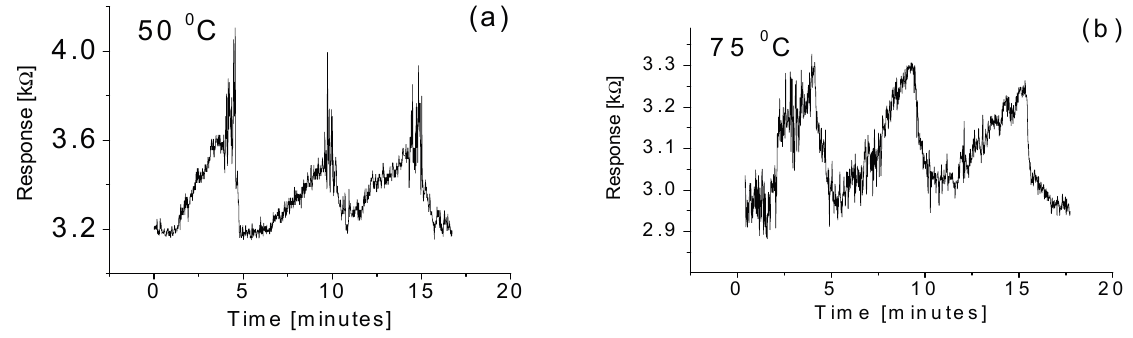
Figure 8. Responses of the sensor to the methane gas with a 2 ppm concentration at operating temperatures of ( a ) 50 °C; and ( b ) 75